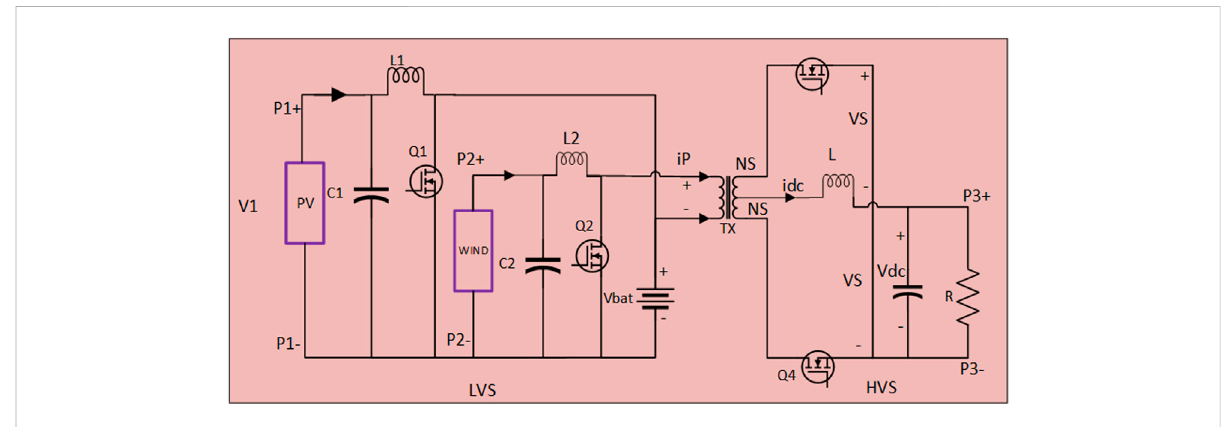
FIGURE 4 Proposed isolated, three-port, bidirectional DC-DC